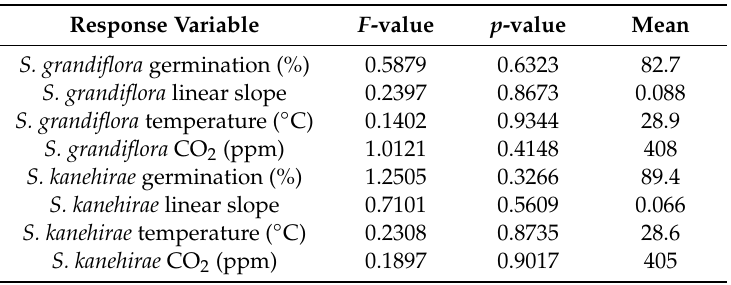
Table 1. Parameters from repeated measures analysis comparing the manner in which Serianthes germination percentage and slope of the linear increase in seed respiration were influenced by pre-scarification incubation times. Seeds were incubated in wet paper towels for 0, 2, 4, or 6 weeks prior to scarifying the seed coat to enable imbibition, n = 6.